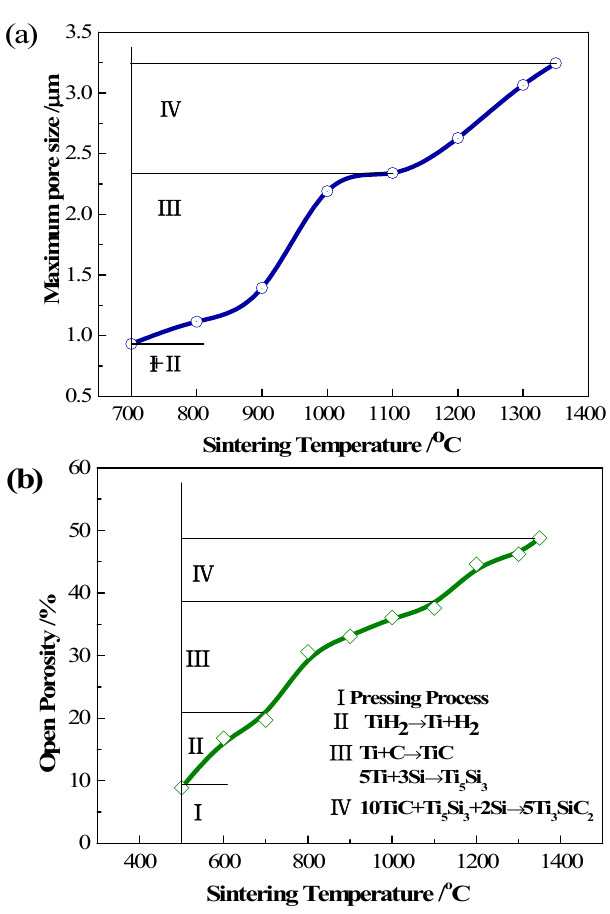
Figure 3. ( a ) The maximum pore size and ( b ) open porosity as a function of the sintering temperature.